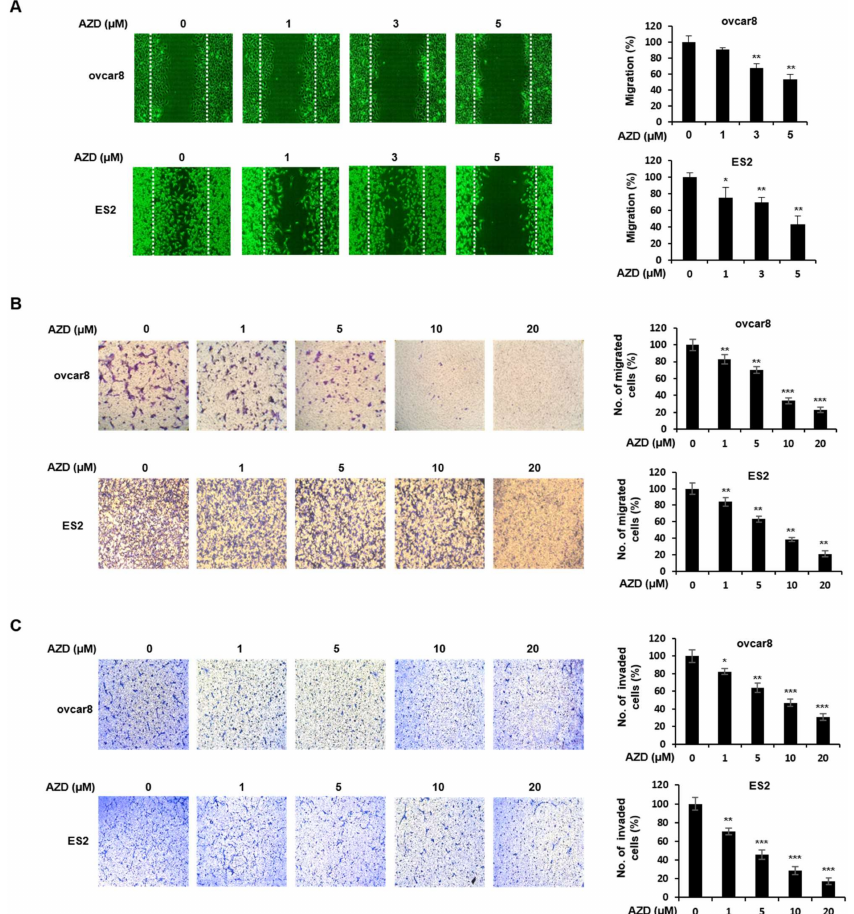
Figure 4. AZD4547 inhibits the migration and invasion of ovarian cancer cells. ( A ) Ovcar8 and ES2 cells were treated with thymidine and AZD4547 for 30 h. White lines indicate the wound borders at the beginning of the assay. Left panel, representative figures from three independent experiments. Right panel, quantification of the percentage of cell-covered area of the corresponding experimental group. ( B , C ) Ovcar8 and ES2 cells were treated with AZD4547 for 24 h. Cell migration ( B ) and invasion ( C ) were determined by transwell assay. Left panel, representative images of migrated cells. Right panel, quantification of migrated and invaded cells in the corresponding group. AZD, AZD4547. * p < 0.05, ** p < 0.01, *** p <